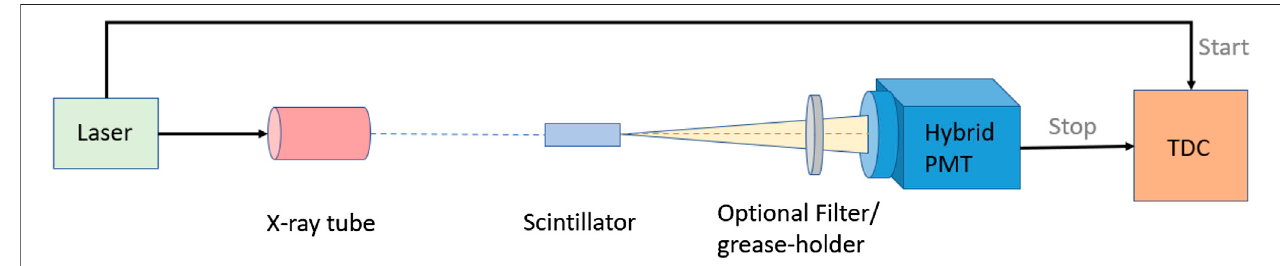
FIGURE 2 | Illustration of the time correlated single photon counting (TCSPC) setup, using an X-ray tube excited by a picosecond laser, hybrid-PMT, and a fast TDC. Filters can be placed in front of the hybrid-PMT.